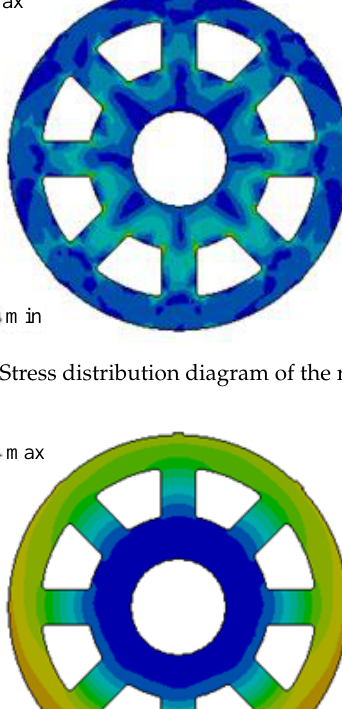
Figure 16. Stress distribution diagram of the rotor shutdown condition.